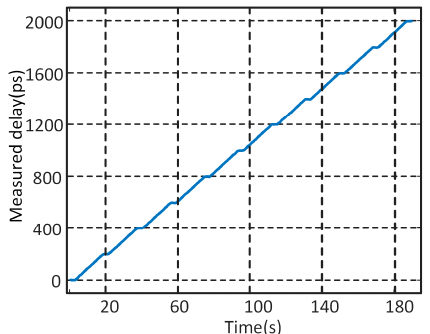
Figure 9. Measurement results when FTD varies with a step of 200 ps. ( a ) measured peak frequencies (red) and peak phases (blue); ( b ) the number of periods (red) and normalized phases (blue).